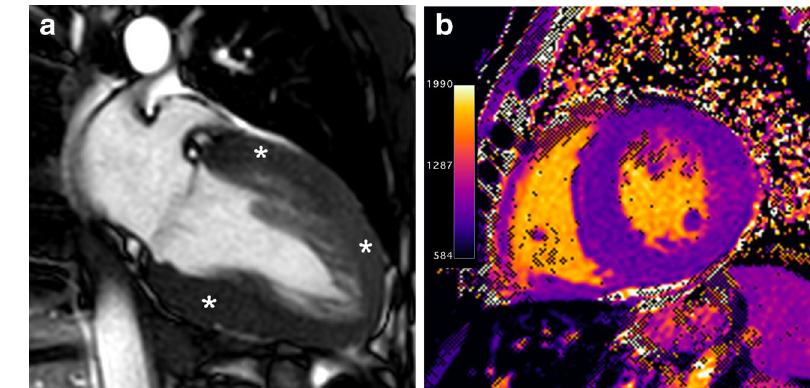
Fig. 10 45-year-old man with gene-positive Anderson-Fabry disease. a , End-diastolic fouchamber SSFP cineMRimage shows diffuse and symmetric LV wall hypertrophy (asterisks). b , Non-enhanced short-axis MOLLI native T1 map at 1.5 T shows significant shortening of T1 values (840 ms) in the hypertro- phy segments. Post-gadolinium images were not obtainedby